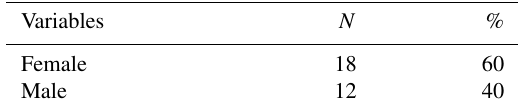
Table 1. Patient demographics and surgical information.